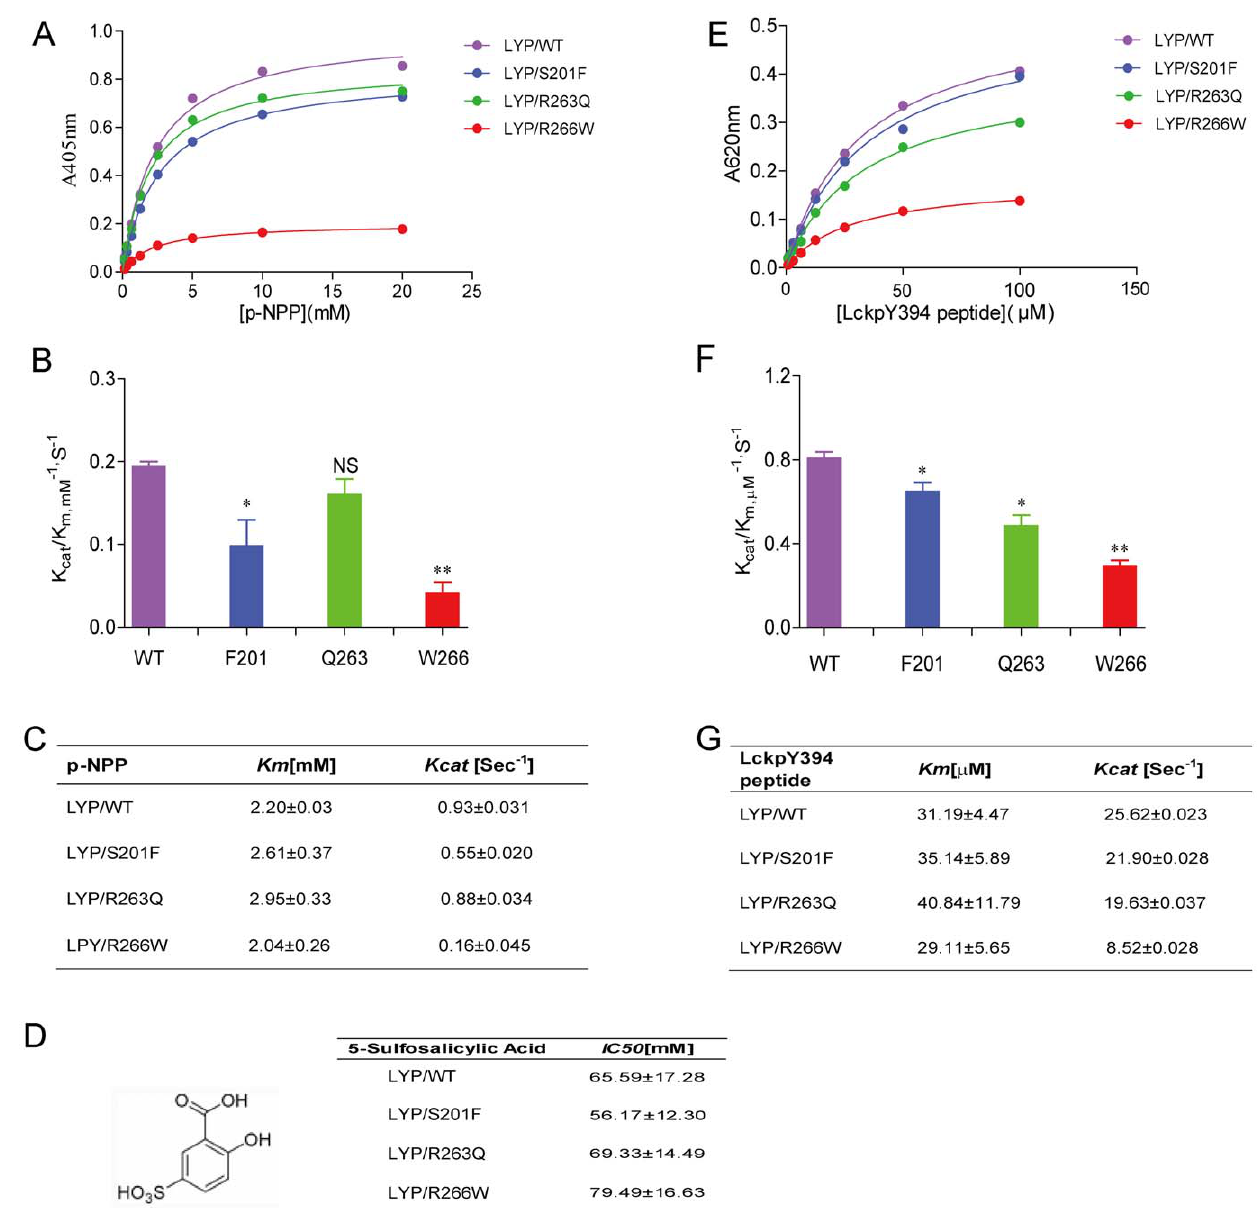
Figure 2. Kinetic analysis of the phosphatase activity of Lyp catalytic domain wild type and S201F, R263Q and R266W mutants toward pNPP and phosphor-peptide. (A) pNPP hydrolysis with Lyp catalytic domain domain and 3 mutants. Data were fitted to the Michaelis- Menten equation. (B–C) Kinetics parameters for the wild-type and the mutants of Lyp toward pNPP. All experiments were repeated four times. * represents P , 0.05; ** represents P , 0.01. (D) IC50 values of 5- sulfosalicylic acid toward Lyp wild type and variants. (E) Lyp catalyzed phosphate release of a 9 amino acid phosphor peptide derived from Lck 394 phosphorylation site (EDNEpYTARE). Data were fitted to the Michaelis-Menten equation. (F–G) Kinetics parameters for the wild-type and the mutants of Lyp toward EDNEpYTARE. Data showed the mean of three independent experiments. *P , 0.05; ** P , 0.01.